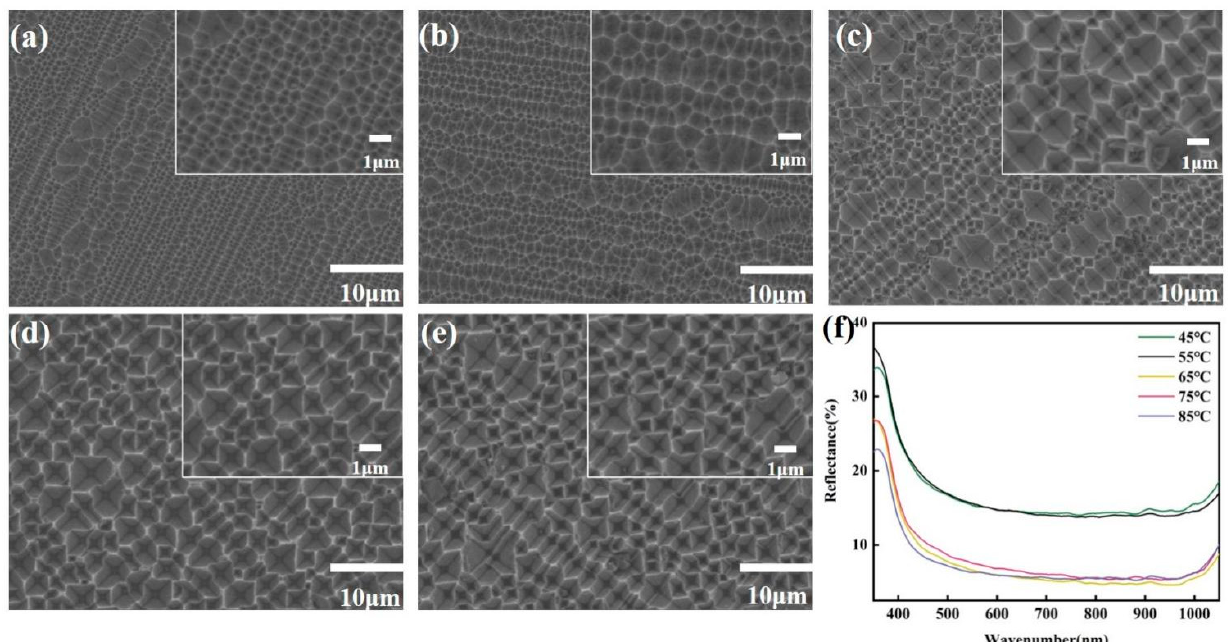
Figure 7. Effect of etching temperature on etched Si surface morphology: ( a ) 45 °C; ( b ) 55 °C; ( c ) 65 °C; ( d ) 75 °C; ( e ) 85 °C and corresponding reflectance spectrum ( f ).